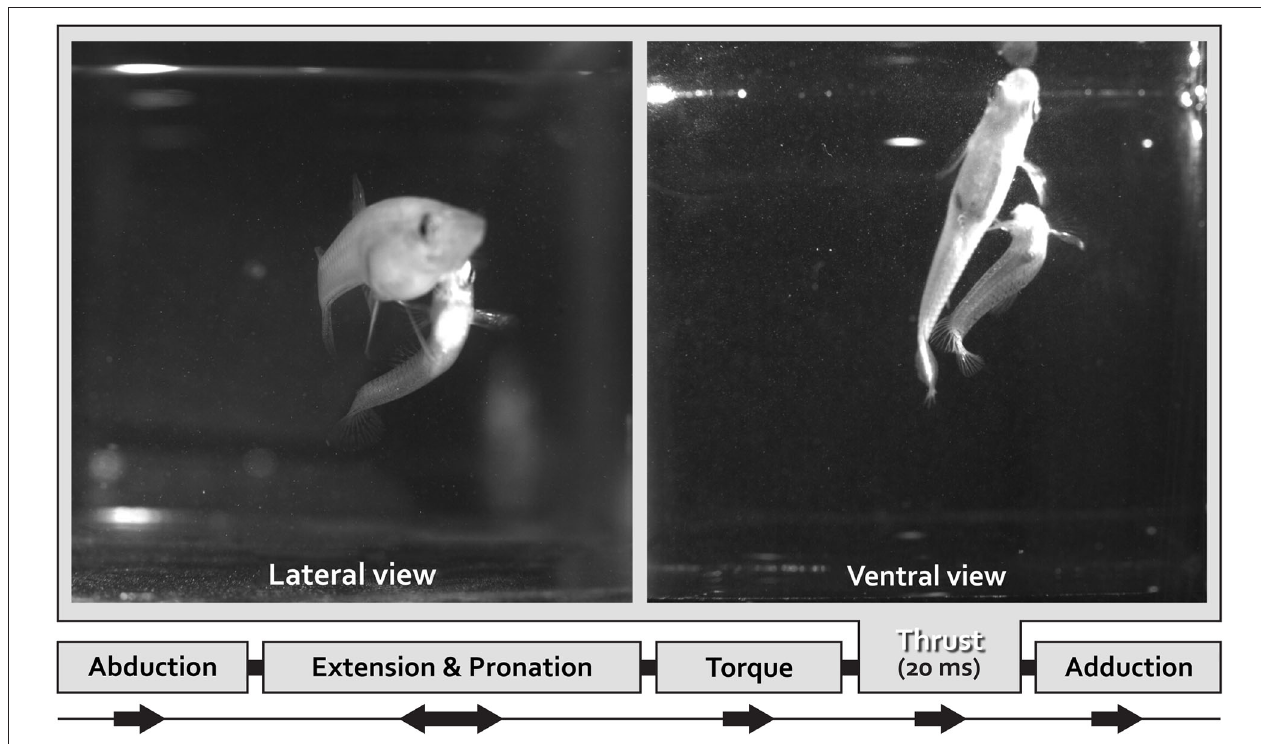
transfer spermatozeugmata, the male Mosquitofish bends his body into an S-shape-type fast-start-like movement (see lateral and ventral view) during the torque-thrust motion of the circumduction of the gonopodium. The sequence ends with the gonopodium adducted. We analyzed the speed of the circumduction of the gonopodium (the specific movements were: abduction, extension and pronation, torque, thrust, and adduction), specifically the fastest portion of the sequence, the “thrust” movement (20